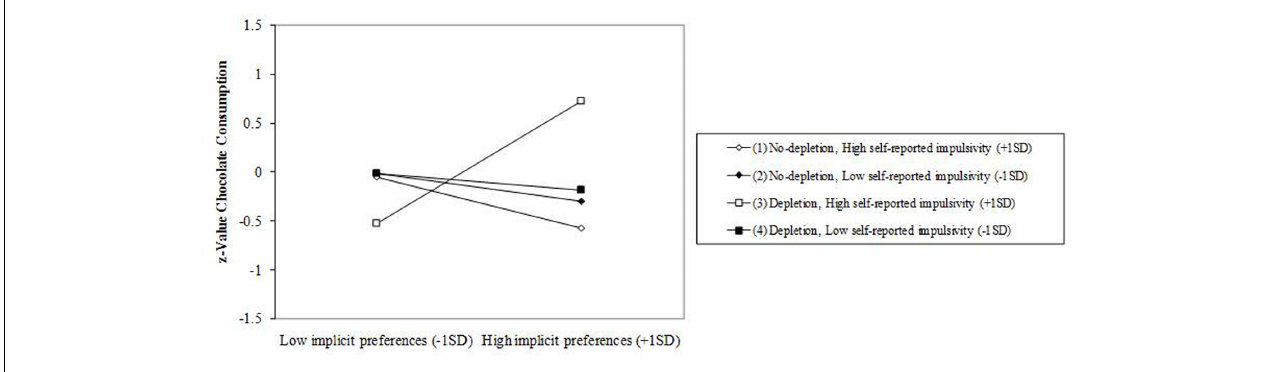
FIGURE 2 | Slopes for implicit preferences-chocolate consumption relationship across levels of ego depletion and self-reported